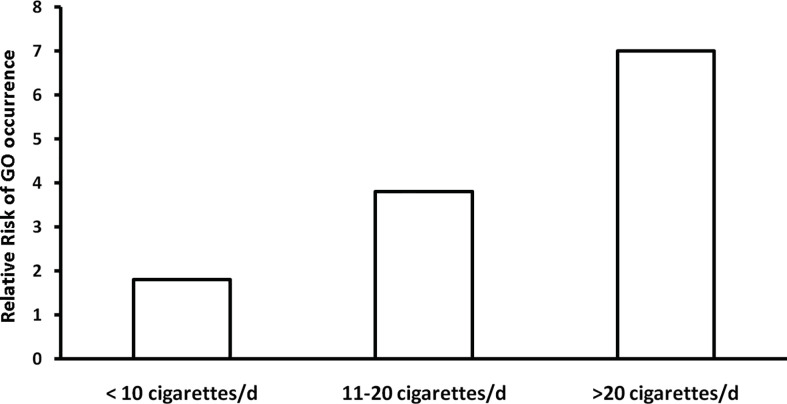
Relative risk of developing exophthalmos and diplopia in relation to daily number of cigarettes. Derived from Pfeilschifter and Ziegler (67).